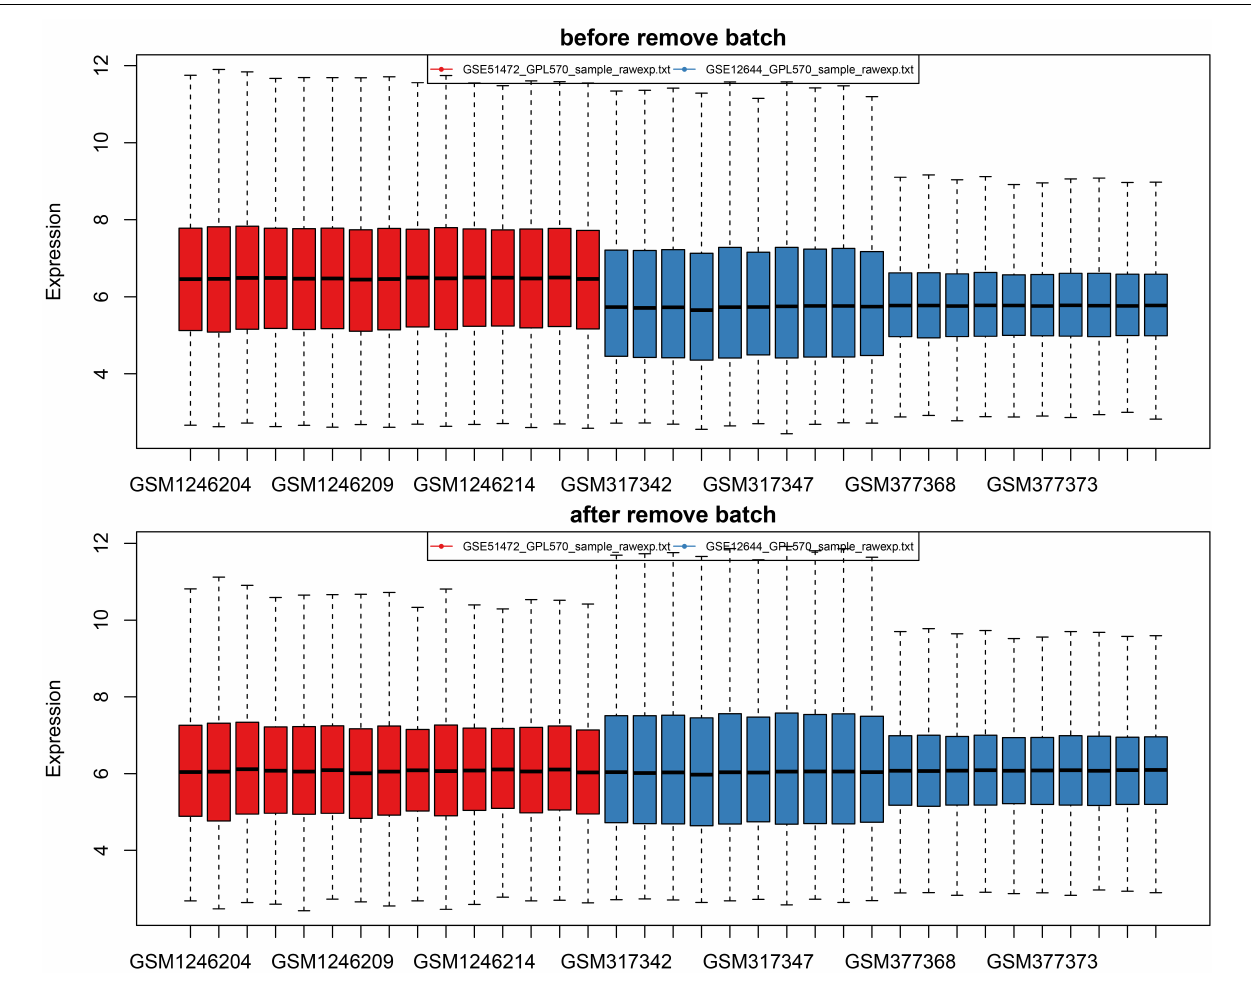
Frontiers in Genetics |